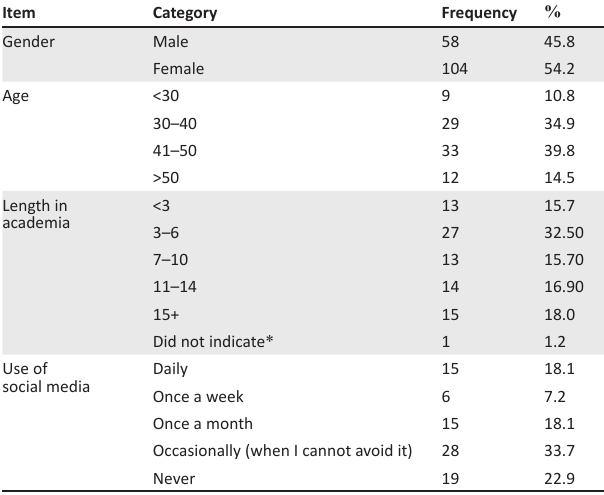
TABLE 1: Demographic details of participants.